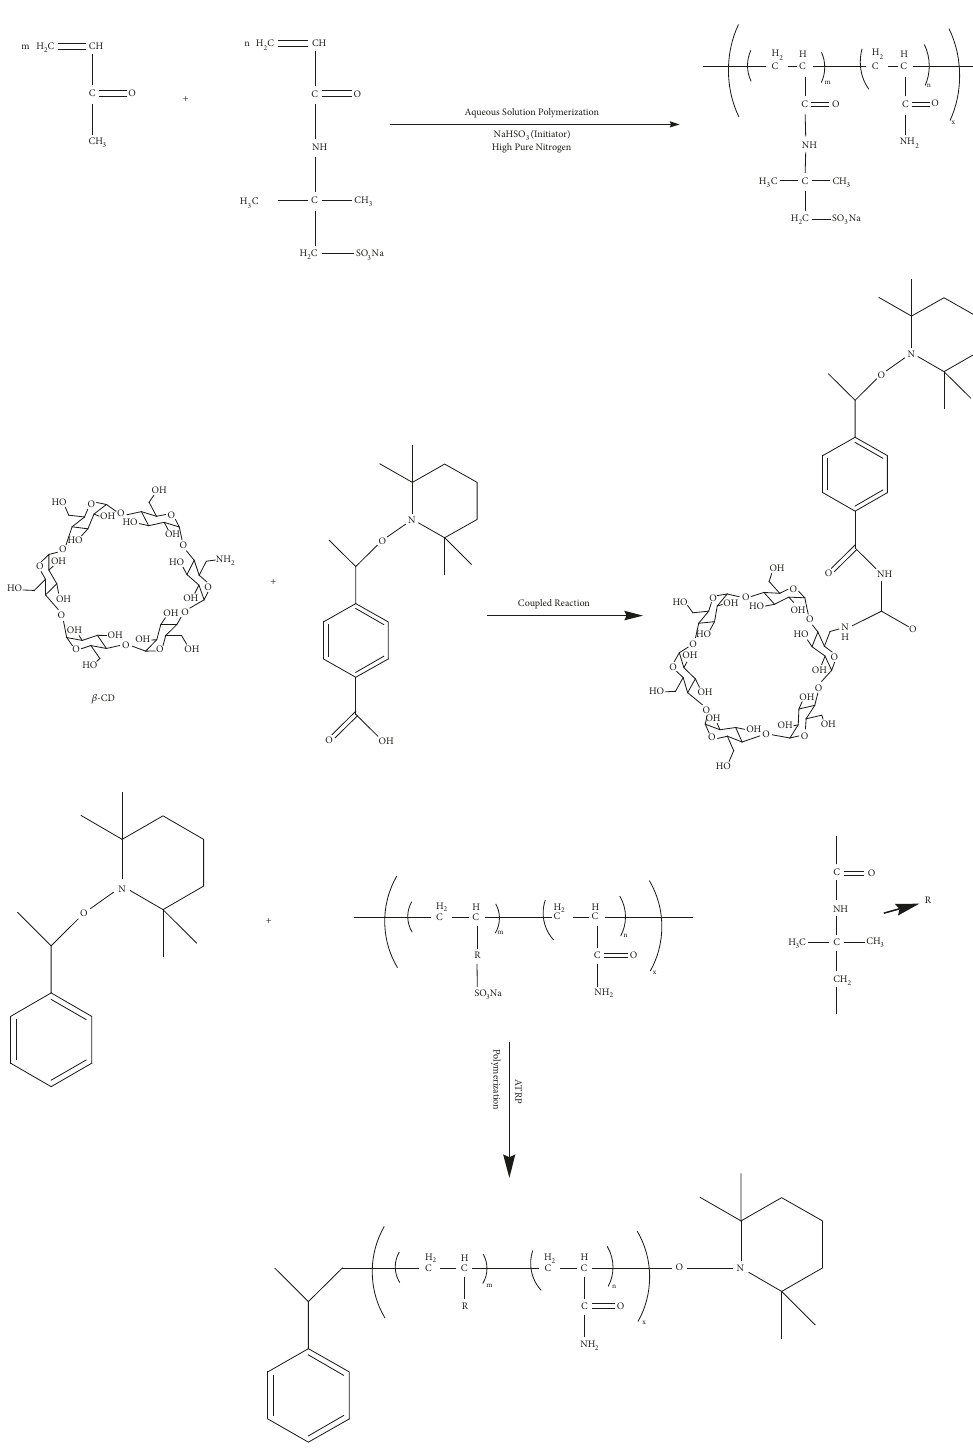
Figure 1: Synthesis of STARPAM with a nucleation of 𝛽